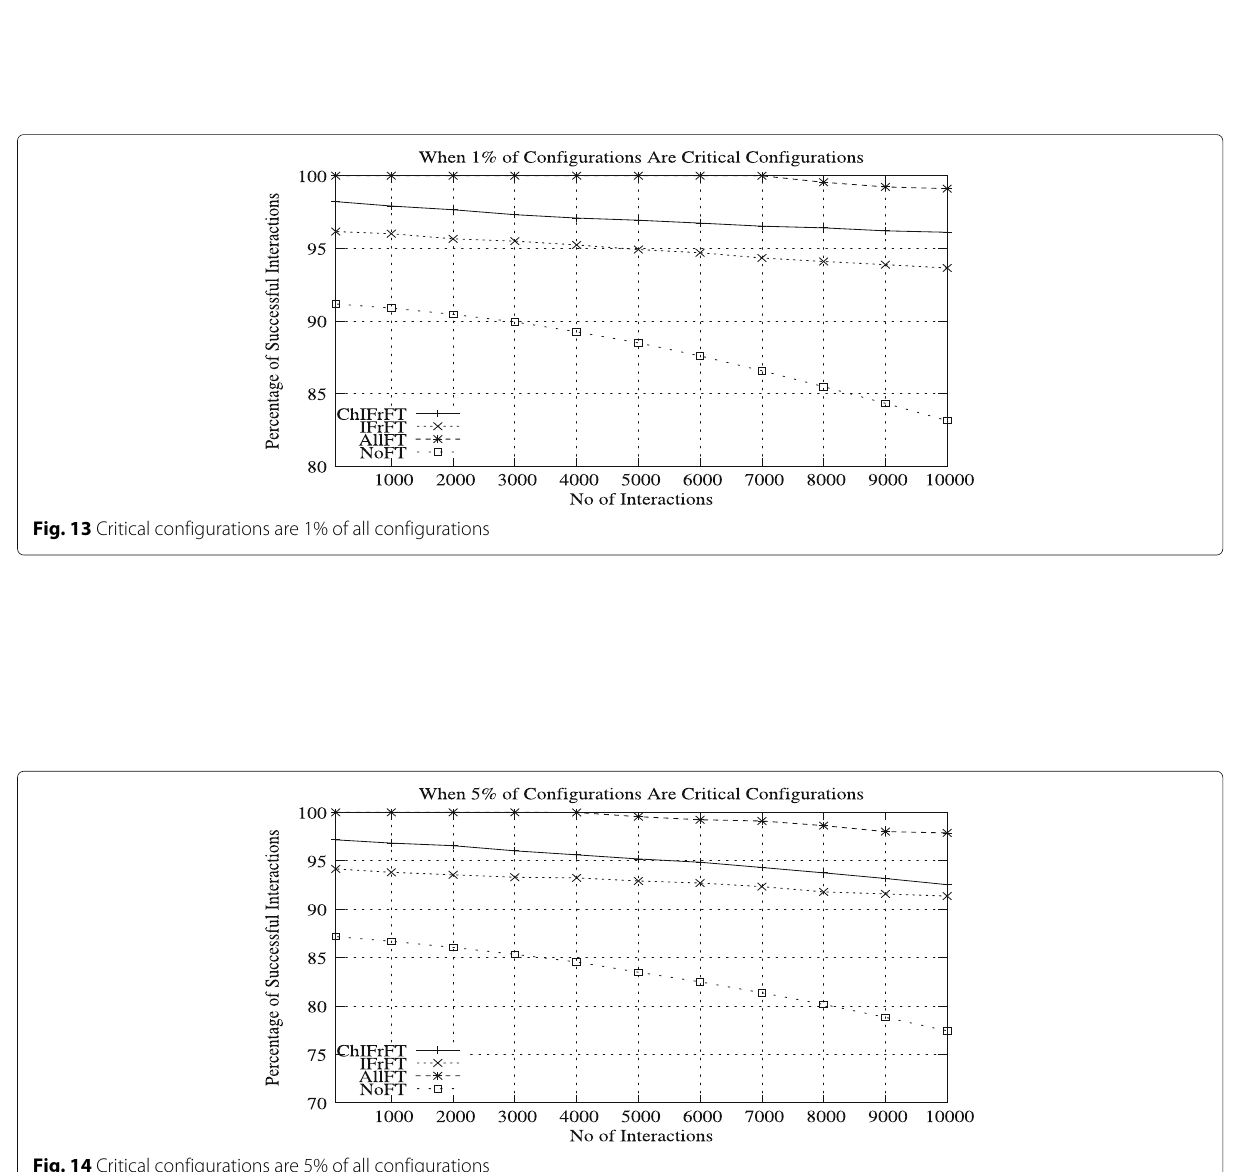
Fig. 14 Critical configurations are 5% of all